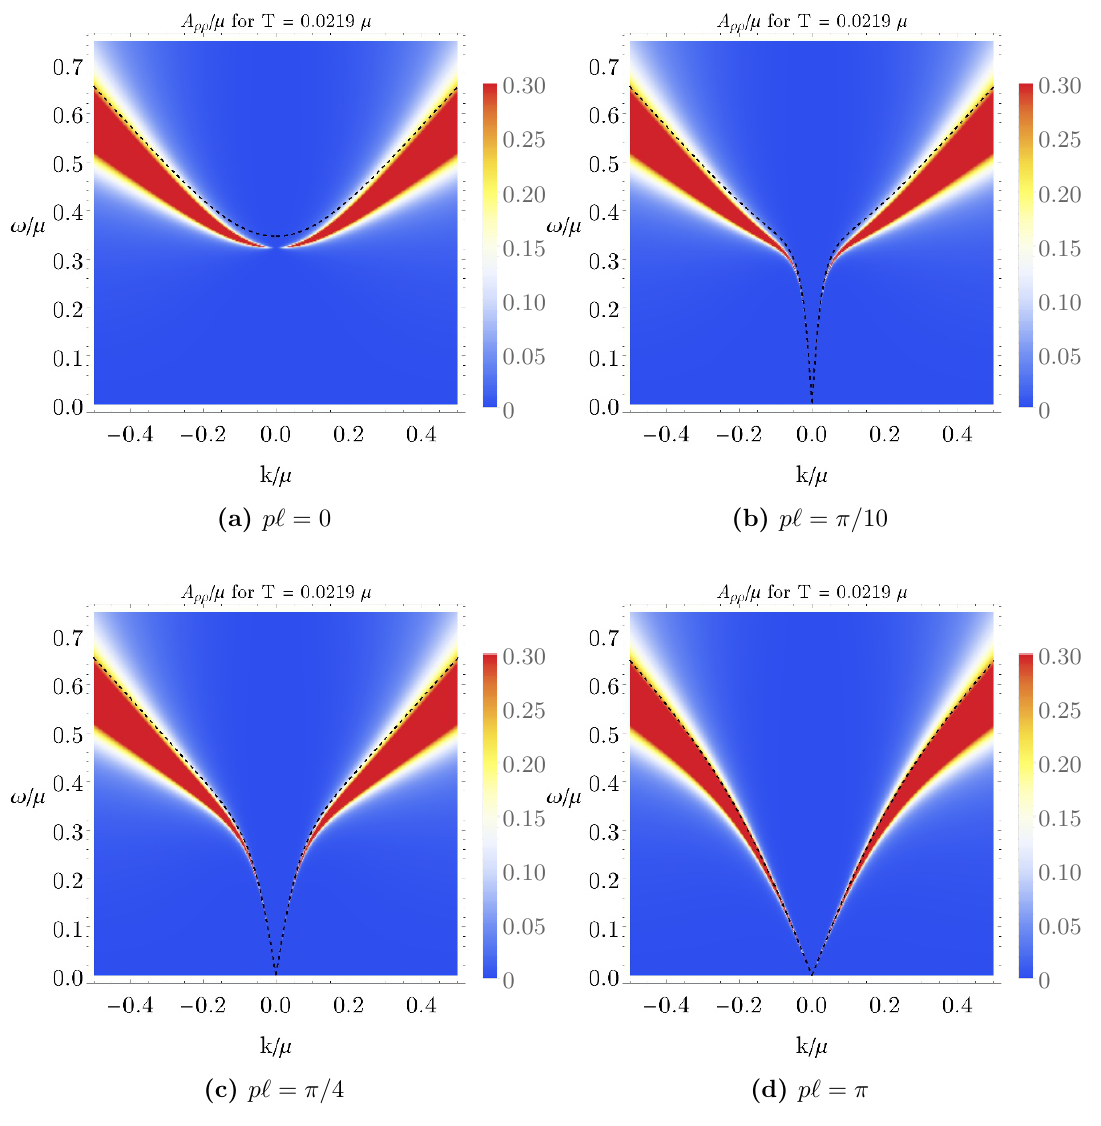
Figure 10. The density spectral function for a layered system at T ’ 0 : 02 (cid:22) . When the sources are in phase (a), i.e., cos( p‘ ) = 1, we recover the gapped mode of (3 + 1)-dimensional materials. However, if the sources are out of phase, for k‘ (cid:28) j cos( p‘ ) j the dispersion relation is linear. We can also observe that for j cos( p‘ ) j (cid:28) k‘ (cid:28) 1, we recover the quadratic modes (b). For k‘ (cid:29) 1 we p instead recover the dispersion relation ! / j k j , as more noticeable in (c)-(d). The black dashed line represent the plasmon modes computed in the hydrodynamic approximation. In all the plots we used (cid:11) 2 = 1 and ‘ =